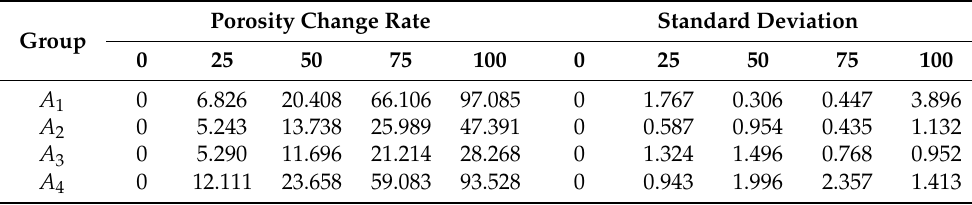
Table 2. Porosity change rates of four groups after different cycles (%).